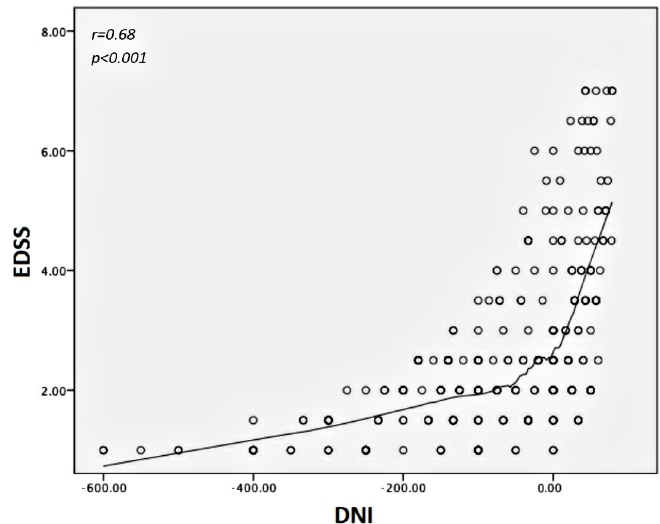
Figure 5. Scatter plot showing statistical correlation between DNI and EDSS scores. Note the increased value of DNI from the low to the high grade of disability, meaning that the main differences in disability between NTZ- and DMF-treated patients are concentrated in the low grade of EDSS. DNI is expressed by the ratio between EDSS scores from patients treated with NTZ and EDSS scores from patients treated with DMF, matched for age, disease duration and age at onset of disease. DNI—Differential Neurological Impairment; EDSS—Expanded Disability Status Scale; NTZ — Natalizumab; DMF — Dimethyl fumarate. Meier curve represents DNI according to the considered age range (Figure 6).